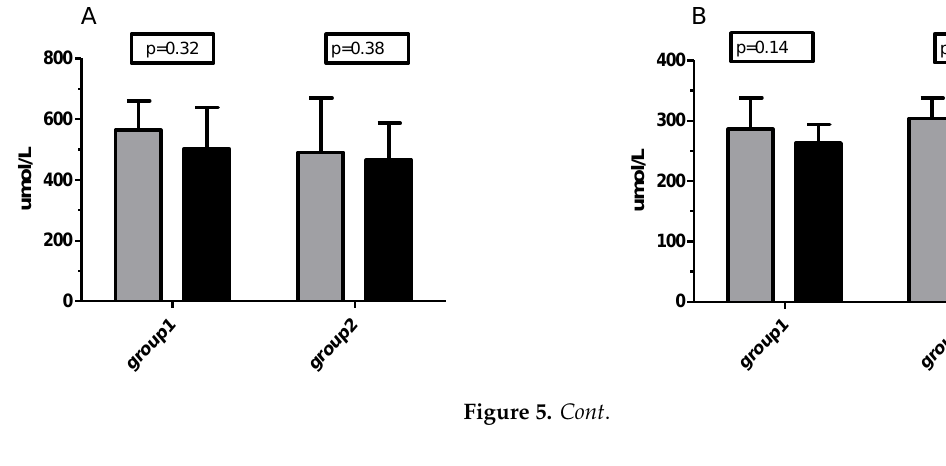
Figure 5. Changes in TOS/TOC ( A ), TAS/TAC ( B ), and prooxidative/antioxidative ratio ( C ) before (grey bars) and after 6 weeks of the unsupplemented training period (dark bars). 4. Discussion In our study, we hypothesized that vitamin C would increase antioxidant capacity and simultaneously decrease oxidative stress and that the expression of genes associated with oxidative stress, such as FTH , FTL, and FOXO3a in leukocytes would decrease. Our findings only partially confirmed these hypotheses. First, after vitamin C supplementation, neither group experienced an increase in TAS/TAC, although both showed a tendency to an increase in TOS/TOC. This means that vitamin C could have a prooxidative effect. During the study period, the prooxidative/antioxidative status remained unchanged at a value of 2.0, indicating high oxidative stress according to reference values. At the same time, plasma vitamin C concentration increased as an effect of supplementation. Second, the decrease in mRNA of FTH and FTL (both significant) as well as of CAT and FOXO3a, and a slight tendency to increase in PCBP1 and PCBP2 mRNA caused by vitamin C did not occur when the participants trained without supplementation. Moreover, the results suggest that the influence of vitamin C on genes associated with iron metabolism is much more important than the applied training. According to the literature, antioxidants may influence both oxidative stress and iron metabolism [22]. The labile iron pool (LIP) is strictly regulated as it is crucial for cell survival, and to prevent iron toxicity [22,23]. One of the most important proteins involved in the prevention of iron toxicity is ferritin, which is encoded by FTH1 and FTL genes. The main function of ferritin is to store iron intracellularly [24], thus it is a key molecule that limits the oxidative stress [3] and is involved in iron homeostasis [25]. Moreover, ferritin gene expression and post-transcriptional regulation of mRNA activity are sensitive to oxidants [23]. Post-transcriptional activity by oxidants is associated with inactivation of IRP1 through reversible oxidation of critical cysteine residues [2]. Some published studies showed a decrease in plasma iron and ferritin after 12 and 32 weeks of Nordic-walking training [26,27]. The findings of these studies indicate that observed changes in iron